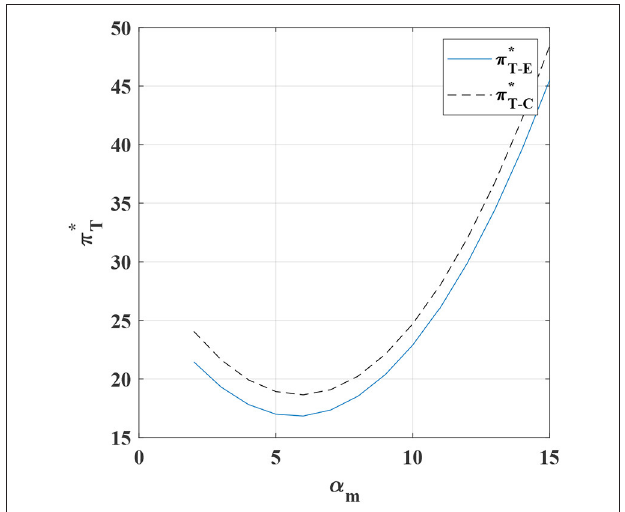
FIGURE 6 | The impact of α m on the overall profit of the system under the different